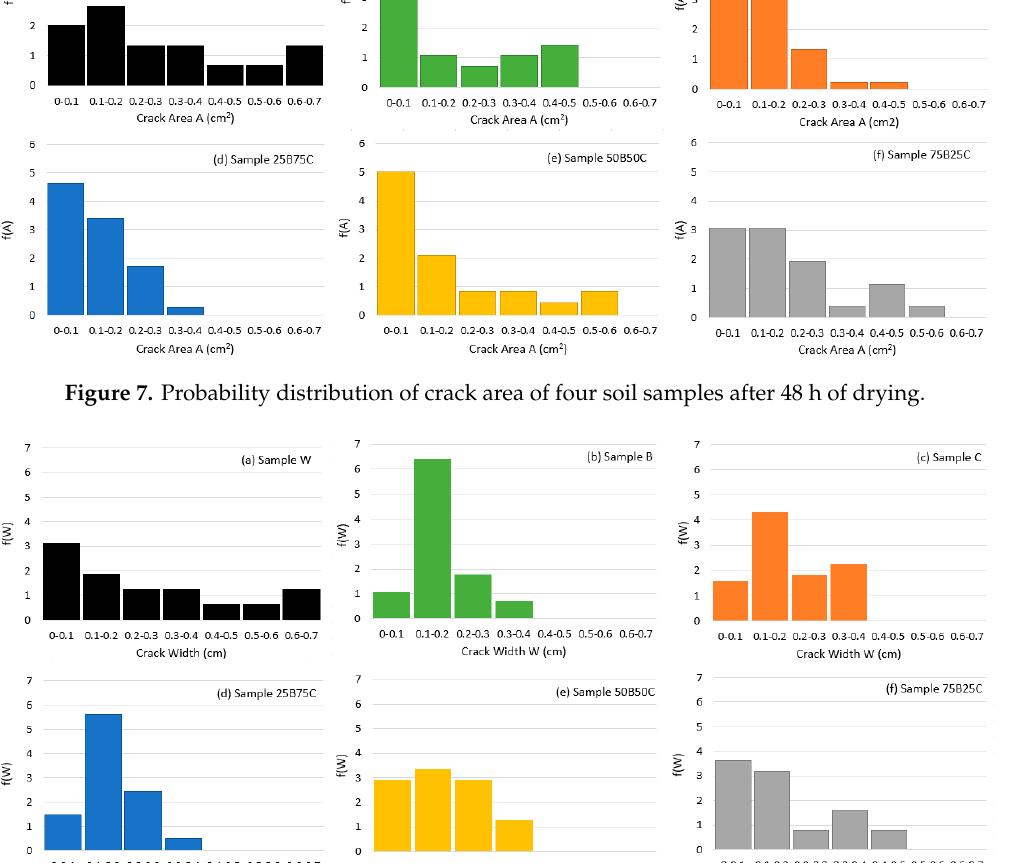
Figure 7. Probability distribution of crack area of four soil samples after 48 hours of drying. 386